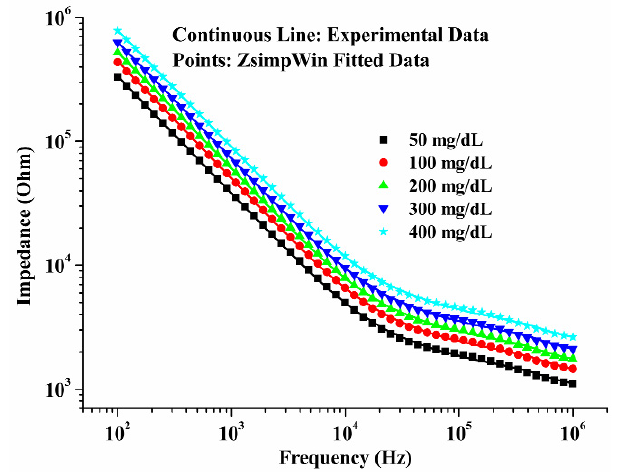
Fig. 4: A typical representation of Bode plot for different glucose concentrations.